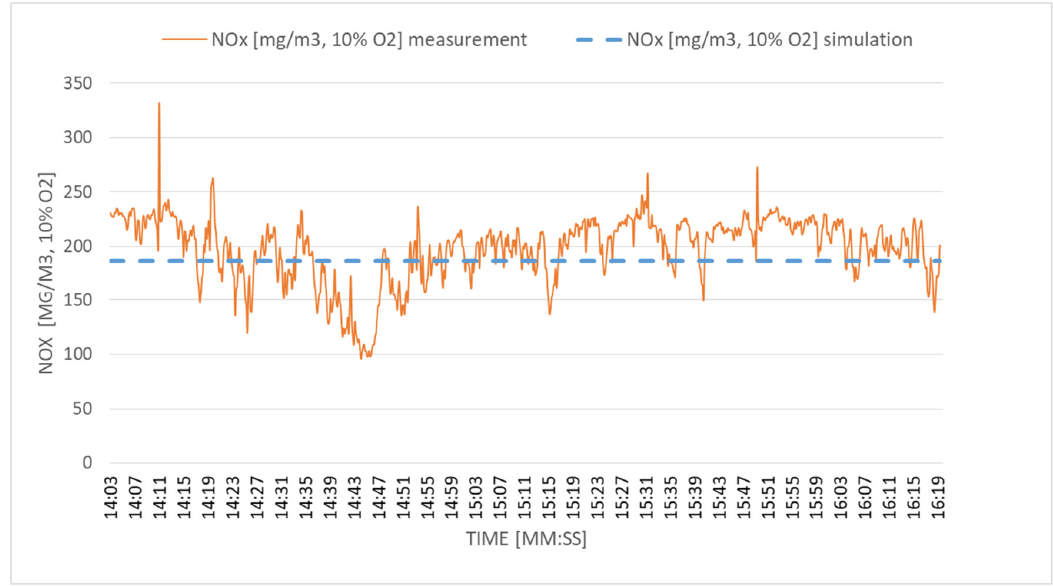
Figure 15. Emissions of nitrogen oxides NO x measured in the chimney.